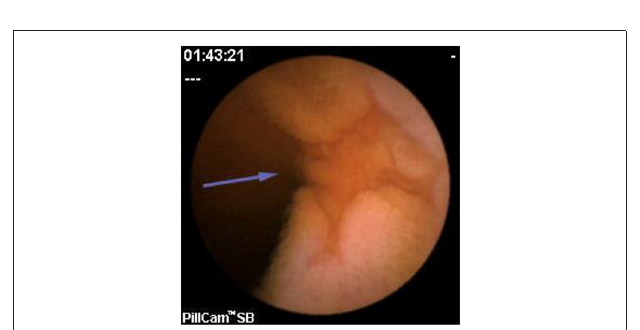
FIGURE 5 | Crohn’s small bowel stricture.